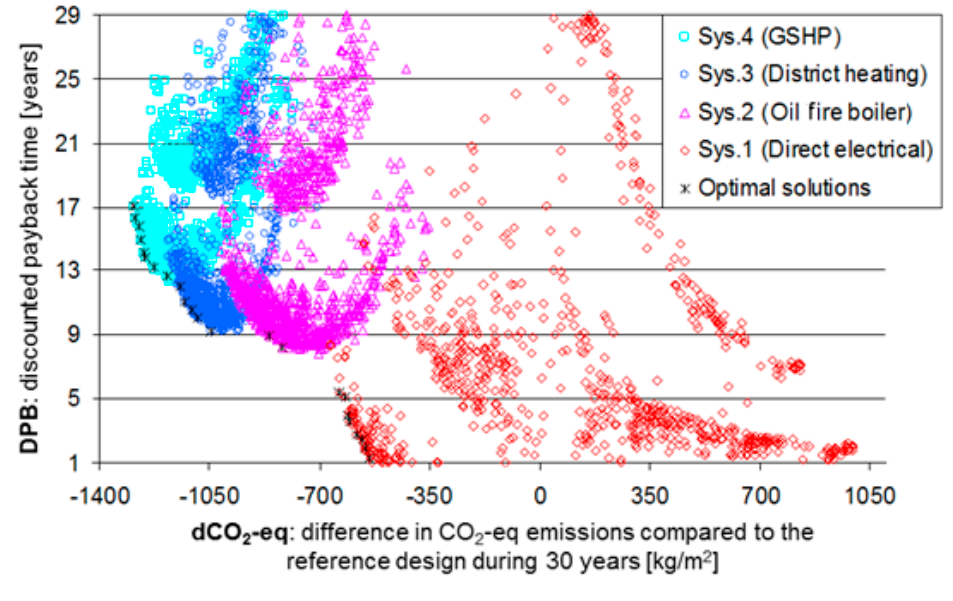
Figure 6. The results of Case 1.